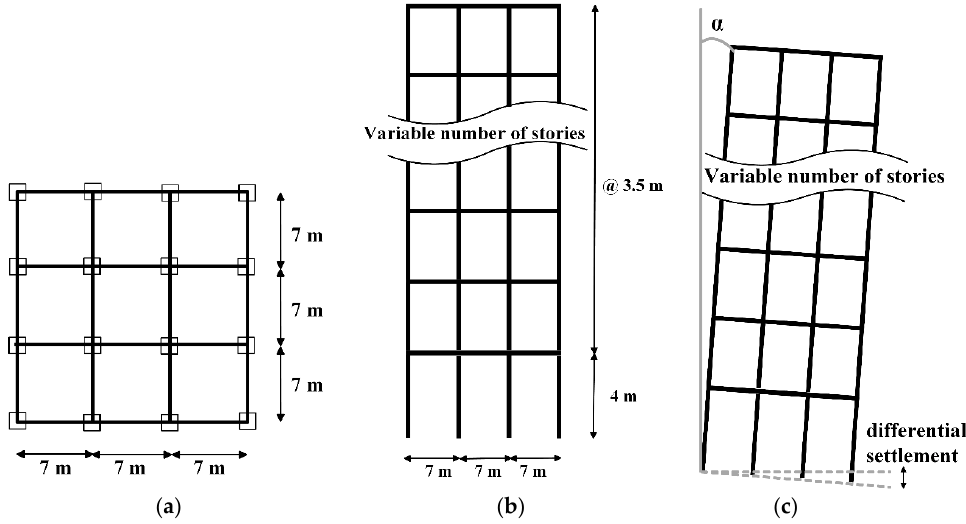
Figure 11. Plan, elevation, and characterization of asymmetric yielding of the buildings. ( a ) plan; ( b ) elevation; ( c ) asymmetric yielding building.